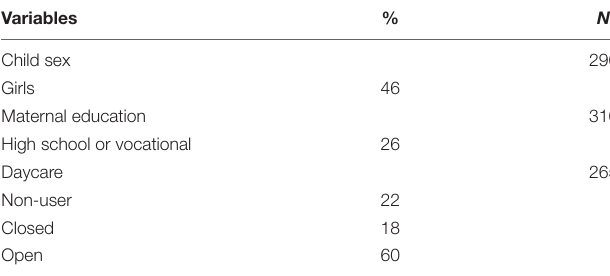
TABLE 2 | Frequencies for categorical variables.